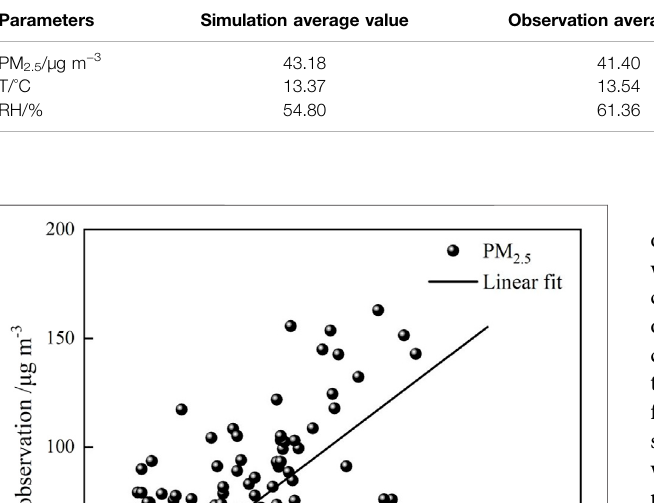
Frontiers in Environmental Science |